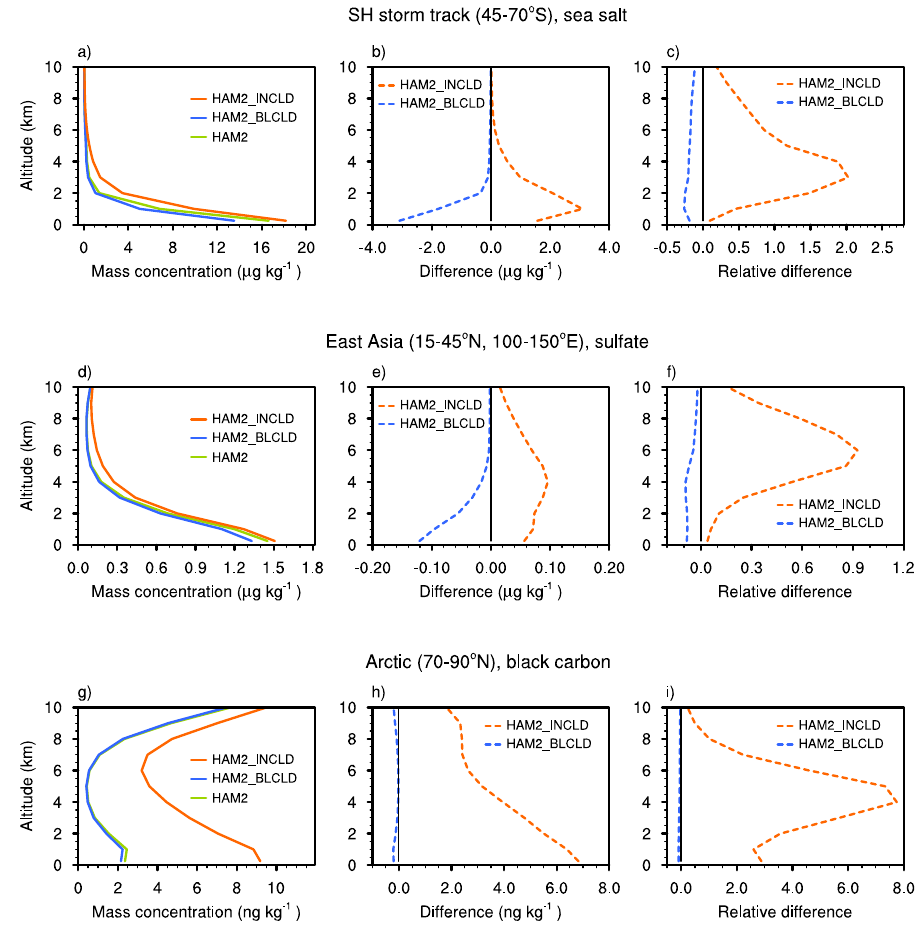
Fig. 8. Annual mean vertical profiles of aerosol mass concentrations in various regions in the sensitivity simulations HAM2 INCLD and HAM2 BLCLD (left panels), the differences (middle column) and relative differences with respect to standard HAM2 (right panels). Further details can be found in Sects. 4.2.1 and